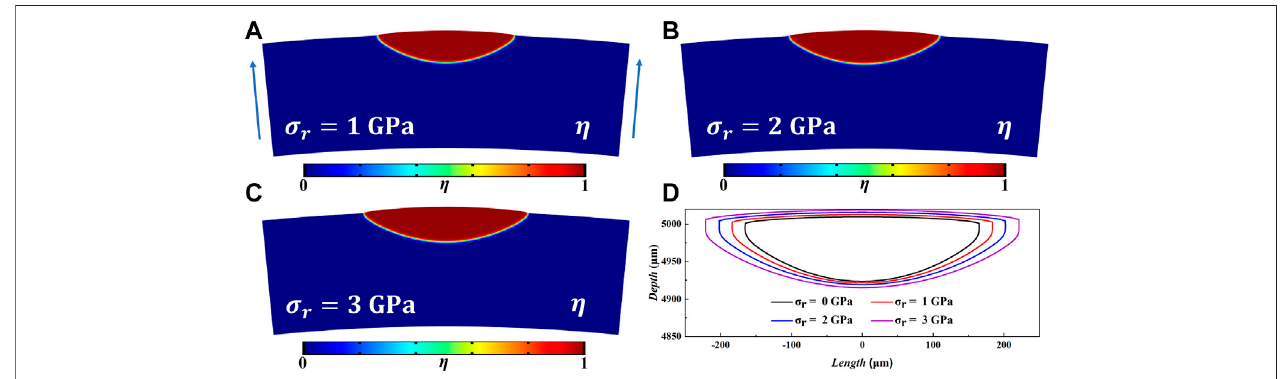
FIGURE5|(A) Thecorrosionpitdepth, (B) theaveragecorrosionrateandtheareaofhydrideblisterasafunctionoftimeunderdifferentradialstresses.Variationof (C) displacement component u x (solid line) and order parameter η (dotted line), (D) displacement component u y (solid line) and order parameter η (dotted line) along the red arrow in the diagram under different radial stresses at t = 1,500 s (The displacement of the green dotted line and the order parameter of the light blue dotted line are zero).